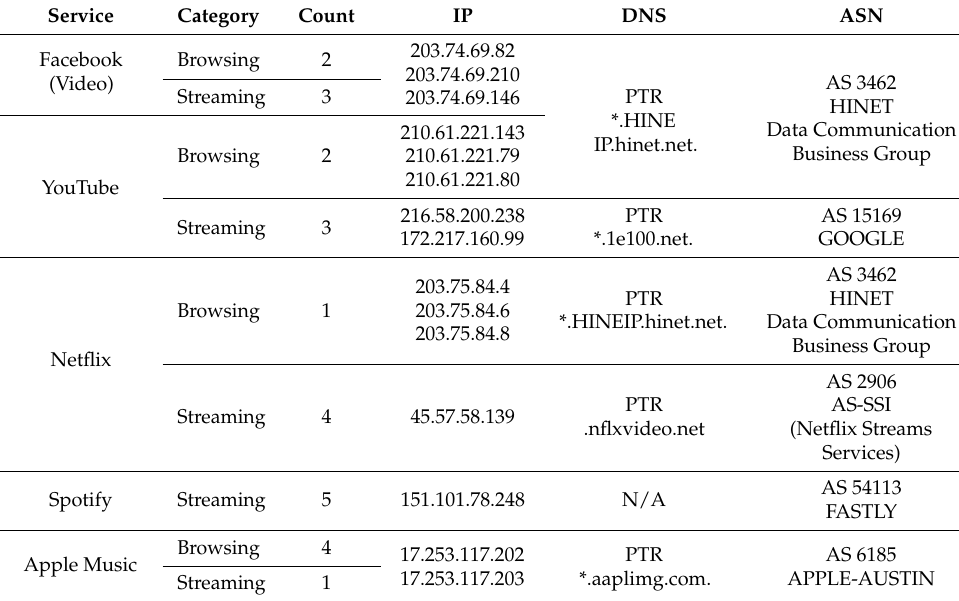
Table 12. Streaming IP/ASN query results. * stands for all.